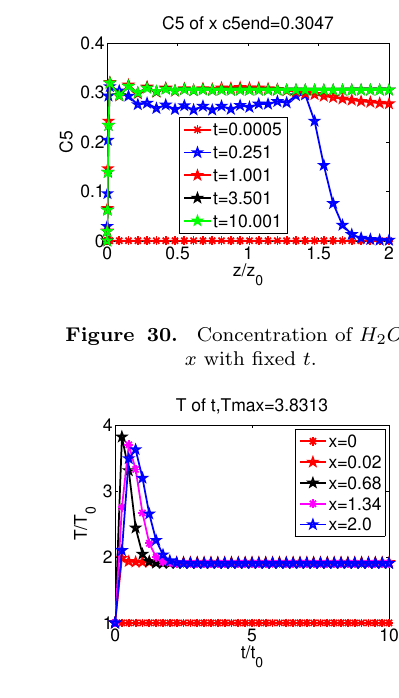
Figure 32. Temperature T vs. t with fixed x .